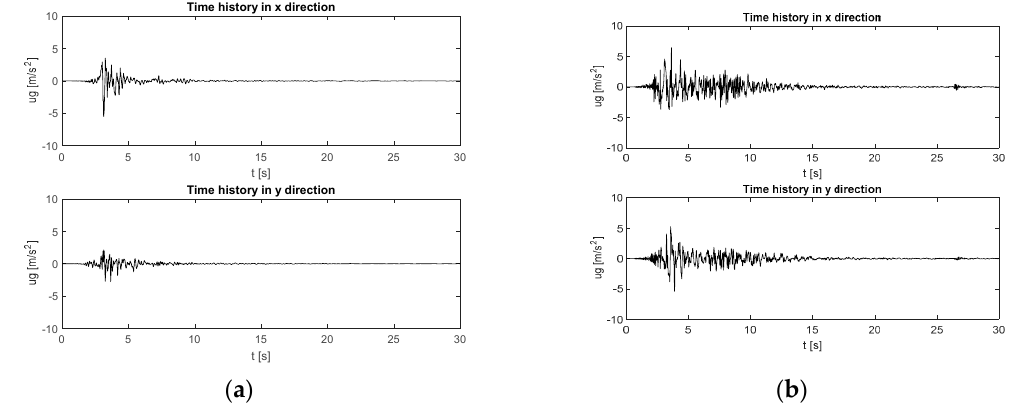
Table 1. Records adopted in numerical simulation.